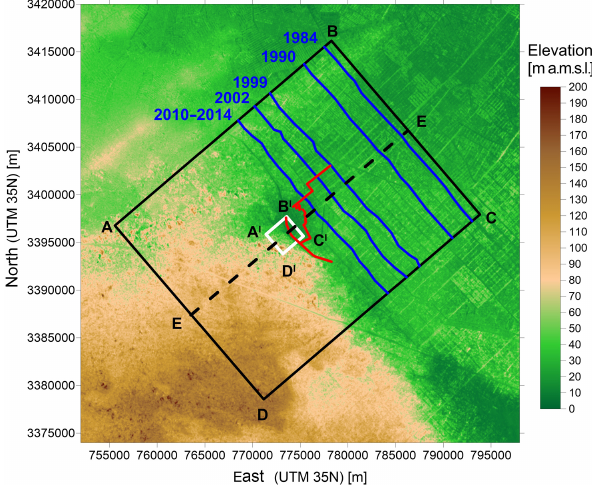
Figure 2. A digital elevation model of the Nubariya depression and its surroundings derived from the ASTER GDEM (Advanced Spaceborne Thermal Emission and Reflection Radiometer; Global Digital Elevation Model) (Tachikawa et al., 2011) and calibrated by a kinematic DGPS in situ survey (red alignment). The boundaries of the regional and local models developed in the framework of the IMPROWARE project are shown by the black and white boxes, re- spectively. The blue lines and associated dates, which separate the desert (to the southwest) from the irrigated areas (to the northeast), indicate how the latter has encroached southwestward over time. This information was obtained form an analysis of Landsat images. The results from the 3-D FE pond-scale groundwater flow model are shown along the black alignment